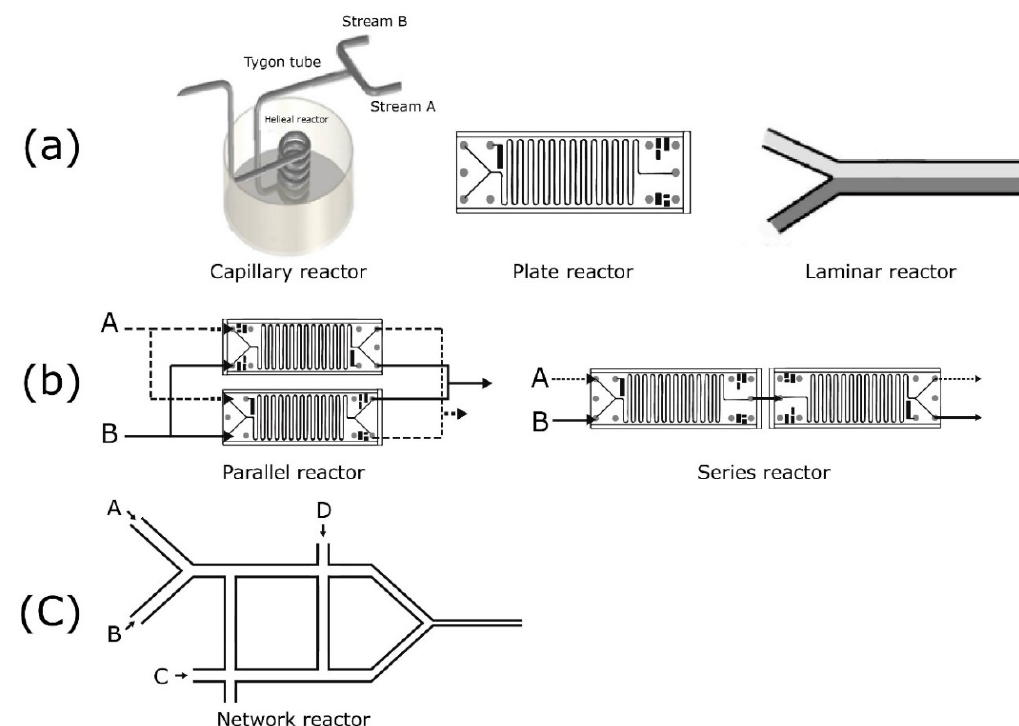
Figure5. Microreactortypes: ( a )typicalreactor[136], ( b )parallelandseriesreactors[43], and( c )network Figure 5. Microreactor types: ( a ) typical reactor [136], ( b ) parallel and series reactors [43], and ( c ) reactor [43]. Images from Šali´c, A.; Tušek, A.; Zeli´c, B.: Application of microreactors in medicine and network reactor [43]. Images from Šali ć , A.; Tušek, A.; Zeli ć , B.: Application of microreactors in biomedicine. Journal of Applied Biomedicine 2012, 10, medicine and biomedicine. Journal of Applied Biomedicine 2012, 10, 137–153.